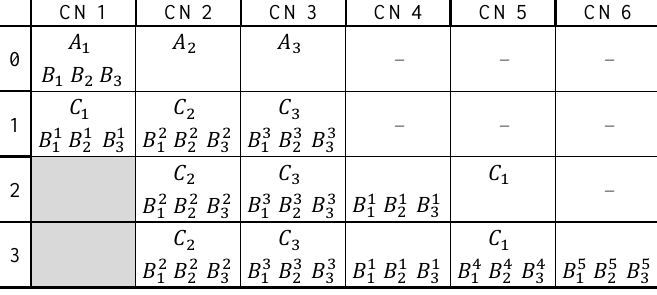
Figure 9. Experimentation